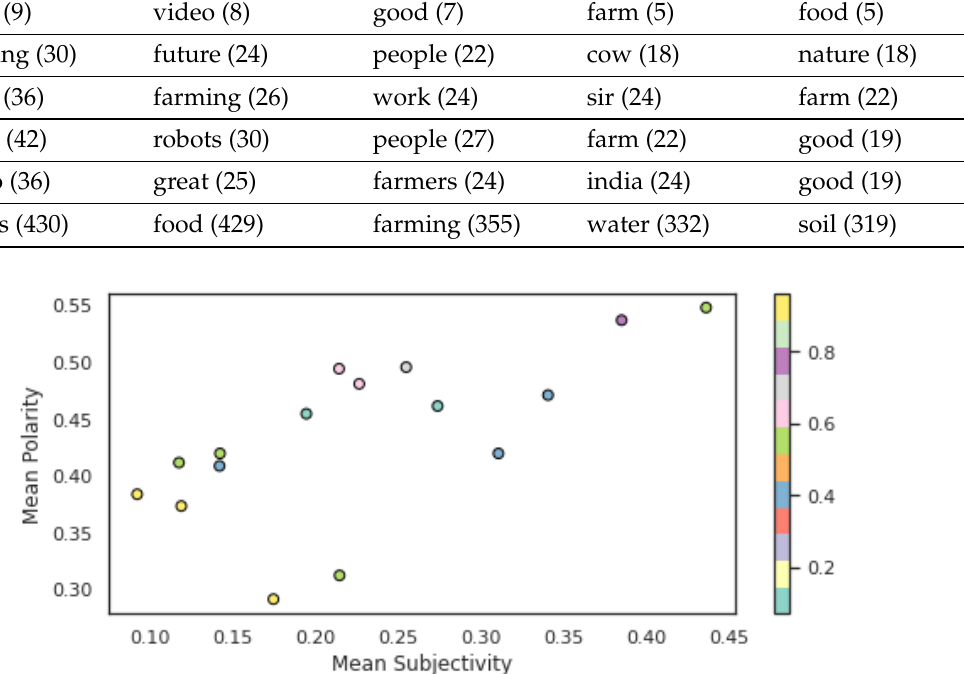
Figure 10. Mean polarity vs. mean